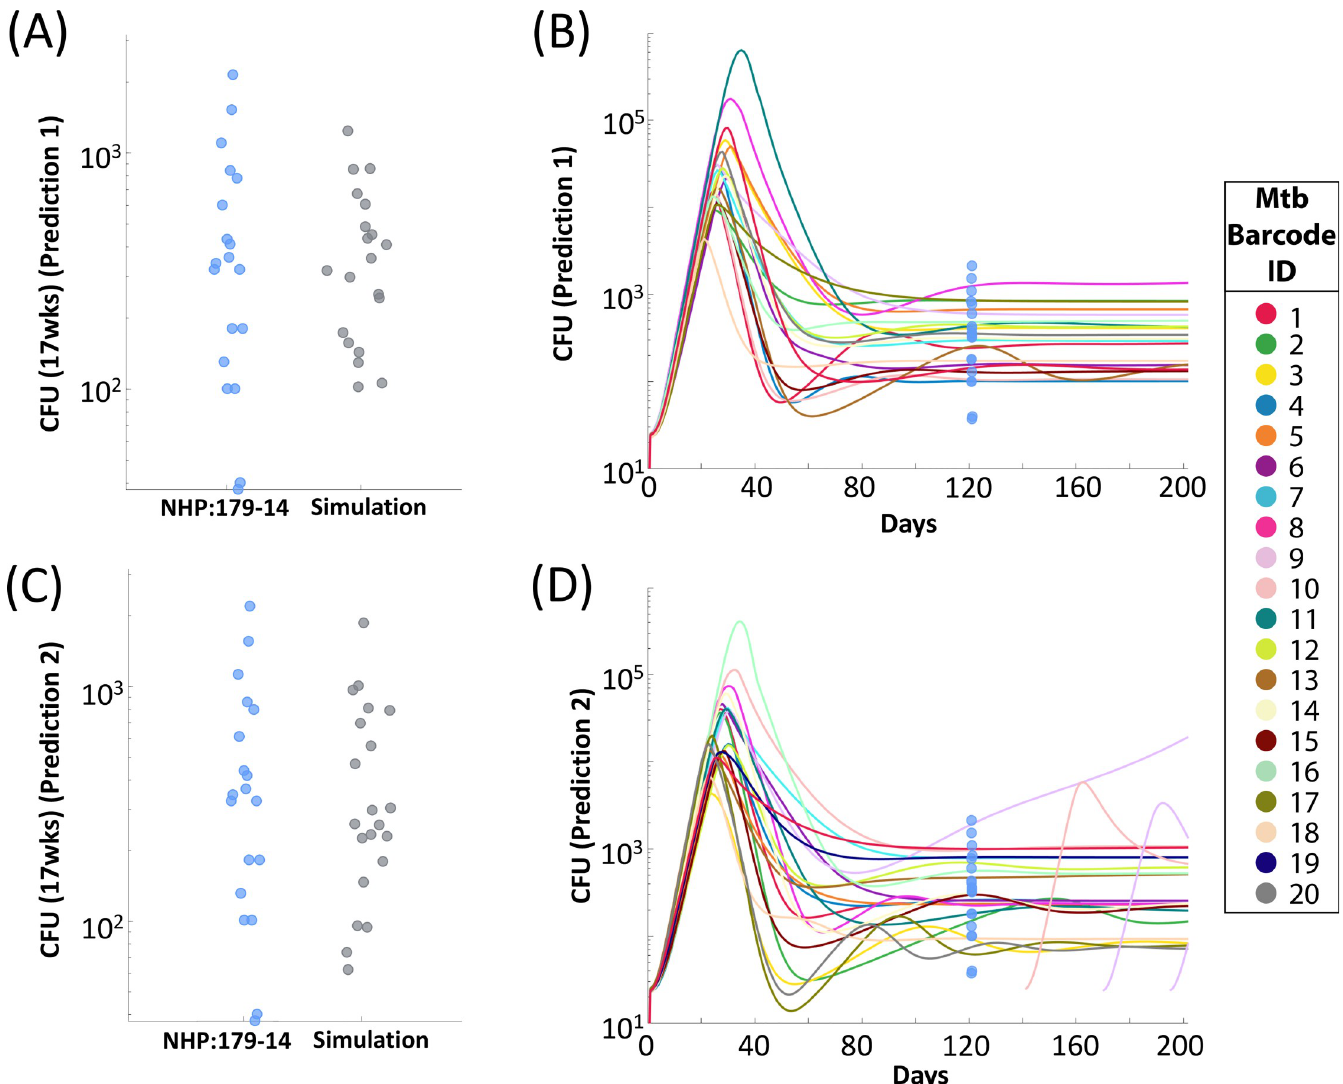
Fig 8. MultiGran matches individual NHP granuloma dynamics and predicts CFU burden across time. We compared the CFU/granuloma at necropsy for NHP:179–14 (A&C) to two separate simulations that matched these outcomes. Blue dots represent single-granuloma values taken from NHP:179–14; gray dots represent simulation values at comparable timepoints. Simulation predictions diverged after 17 weeks. One simulation predicted stability–i.e., granuloma containment of bacteria (B) . The other simulation (D) predicted uncontrolled growth of bacteria within one granuloma, leading to dissemination and the formation of other granulomas across time. Each line in (B&D) represents one granuloma realization within MultiGran across time. Blue dots represent NHP:179 granuloma CFU values. Simulation behavior to the right of the blue dots should be considered a prediction.